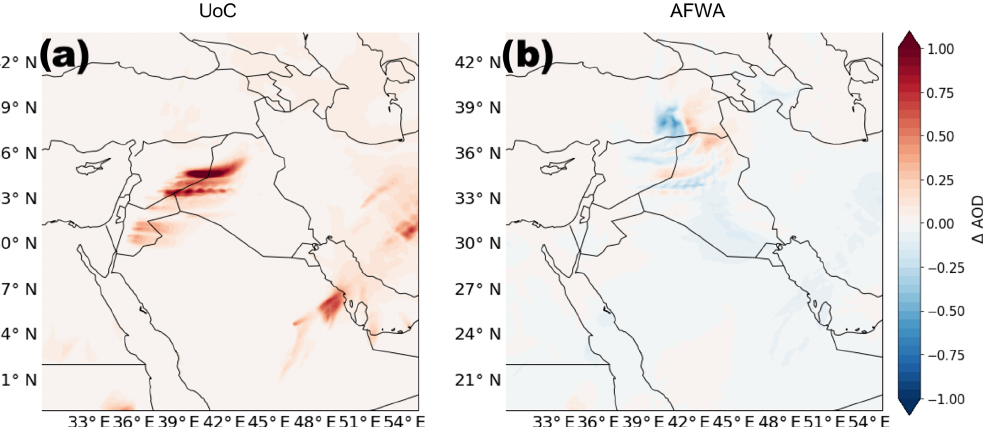
Figure A1. Difference in simulated 8h mean AOD (centered at 10:00UTC on 25 January 2010) produced by the modified and original versions of (a) UoC and (b) AFWA version 3.8.1